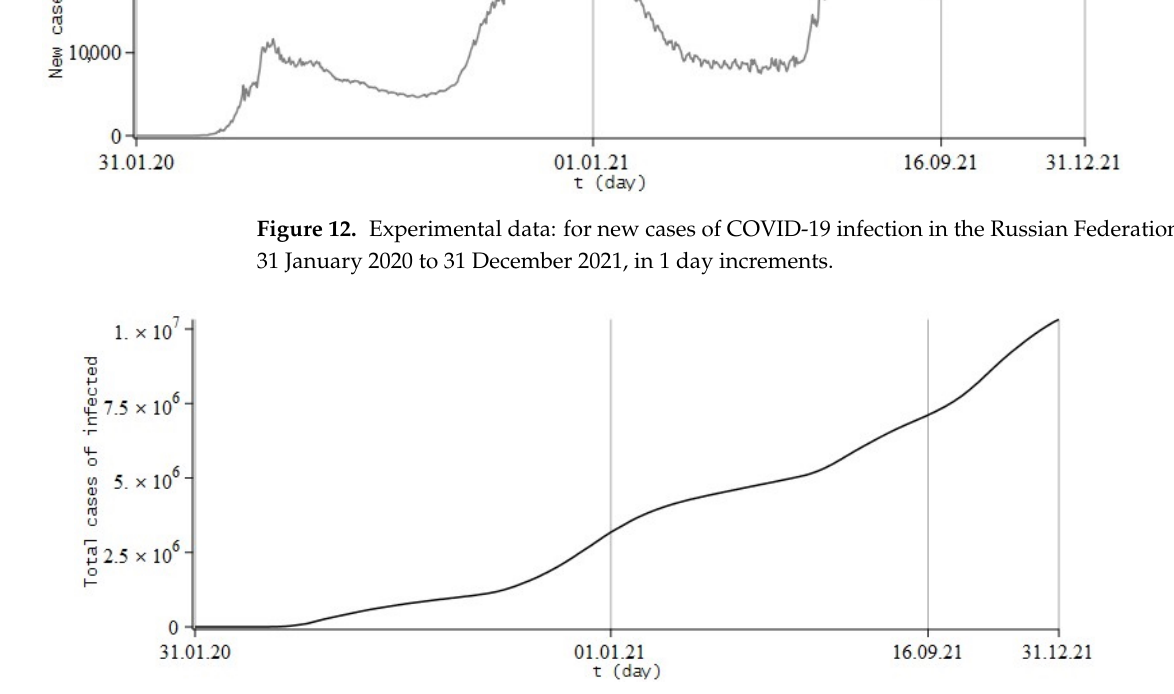
Figure 13. Experimental data: for new cases of COVID-19 infection in the Russian Federation, from